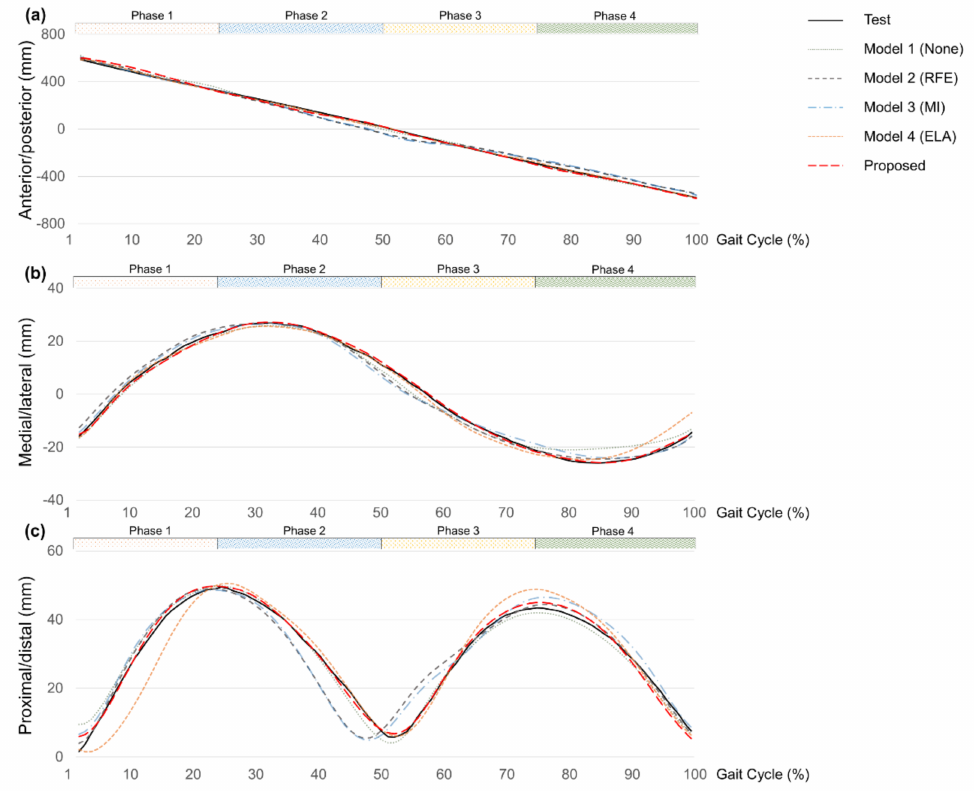
Figure 13. CG trajectories of measurement and prediction (None, RFE, MI, ELA, Proposed). ( a ) Ante- rior/posterior direction; ( b ) medial/lateral direction; ( c ) proximal/distal